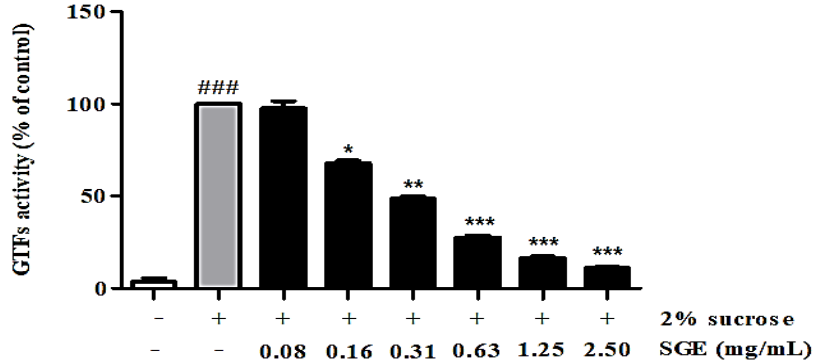
Figure 3. Inhibition of GTFs ’ activity of SGE. GTFs ’ inhibitory activity was measured using a spec- trophotometer of water-insoluble glucan produced by S. mutans , using sucrose as a substrate. Glu- cosyltransferase was pretreated with the indicated concentrations of each sample for 24 h. Values are mean ± SD; ### p < 0.001 vs. non-treated group, * p < 0.05, ** p < 0.01, and *** p < 0.001 vs. 2% sucrose-treated group.